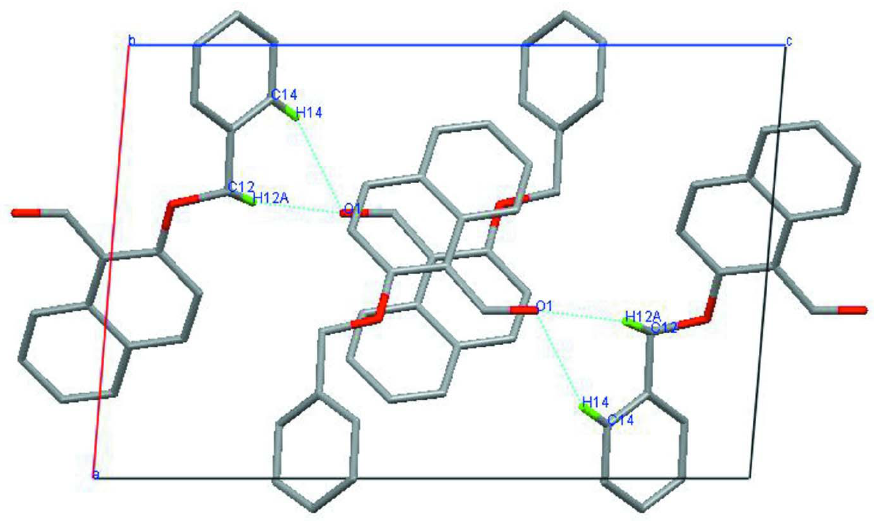
Figure 2 The packing of the title compound, viewed down the b axis. Dotted lines indicate hydrogen